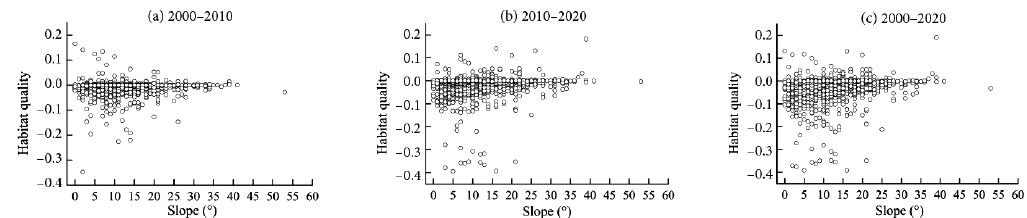
Figure 4. Habitat quality change function of the slope at the pixel scale in